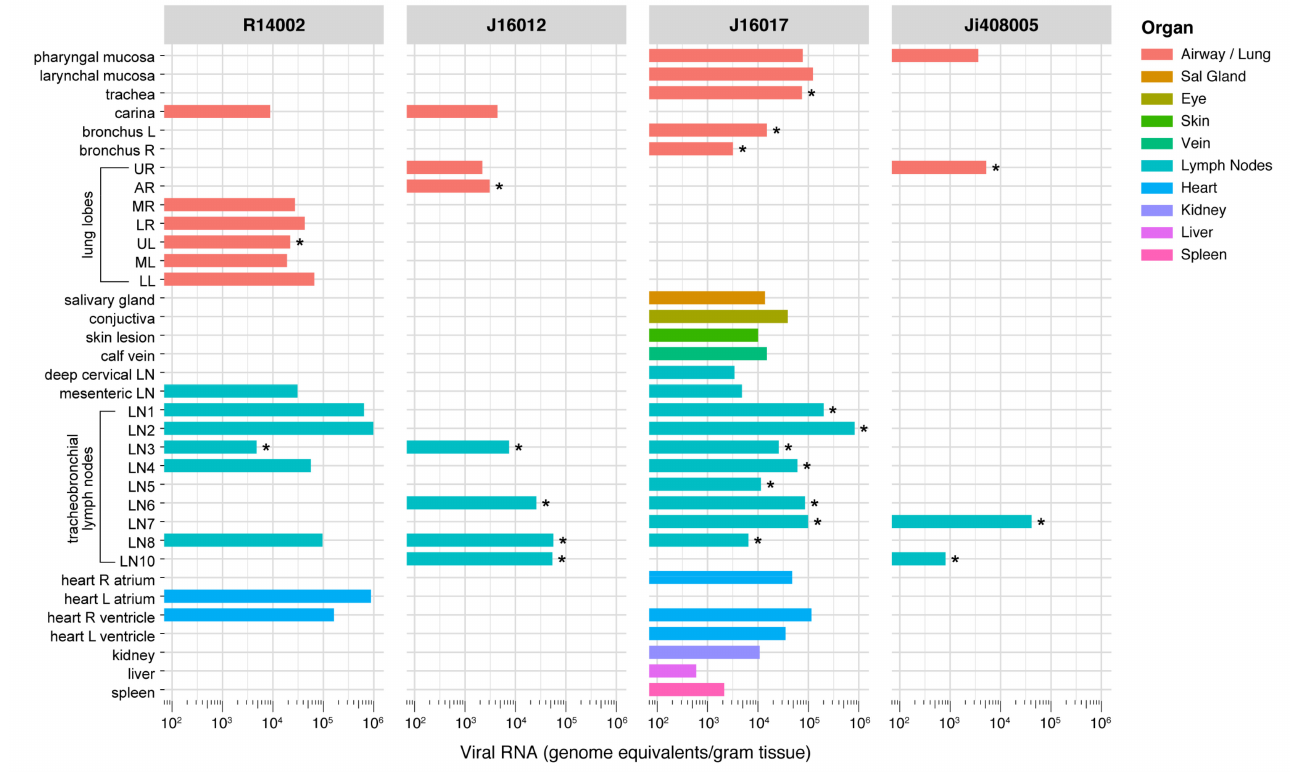
Figure 7. Viral RNA loads in tissues of SARS-CoV-2-infected rhesus macaques (R14002) and cynomolgus macaques (J16012, J16017, and Ji408005). Viral RNA was quantified by qRT-PCR and calculated per gram of tissue. Only animals with viral RNA-positive tissues are shown. On the y -axis, the tissues are listed, on the x -axis the RNA copies per g tissue. Tissues in which no RNA was observed in any of the animals are not shown. The tissues are grouped by color codes as indicated on the right. Tissues that tested positive for sgmRNA are indicated with *. Abbreviations: L, left; R, right; LN, lymph node; UR, upper right lung lobe; AR, accessory right lung lobe; MR, middle right lung lobe; LR, lower right lung lobe; UL, upper left lung lobe; ML, middle left lung lobe; LL, lower left lung